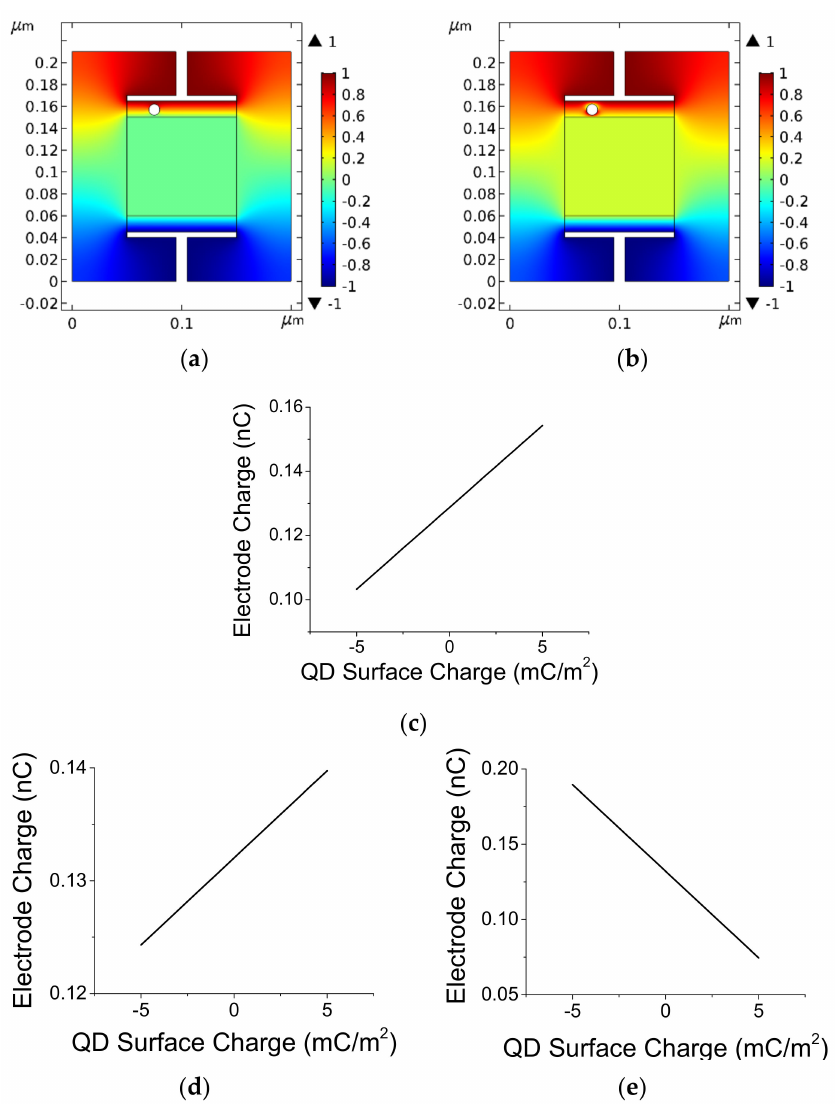
Figure 7. ( a ) Potential distribution when uncharged QD particle is embedded in a graphitic-like electrode. The cell is biased by ± 1 V. ( b ) Potential distribution when the 5 nm particle acts like a dipole. ( c ) Change in the cell capacitance while varying the surface charge density of the dipole for an r = 5 nm particle. Positive surface charge values mean that the QD hemisphere that is away from the positive terminal is decorated with positive surface charges and the QD hemisphere that is closer to the positive terminal is decorated with negative surface charges. ( d ) Change in the cell capacitance while varying the surface charge density for an r = 2.5 nm dipole. Note the relatively large effect even though the overall charge has reduced by a factor of 2.5. ( e ) Change in the cell capacitance while varying the surface charge density of an ionized QD particle with r = 2.5 nm. Here, the charge type is covering the entire QD